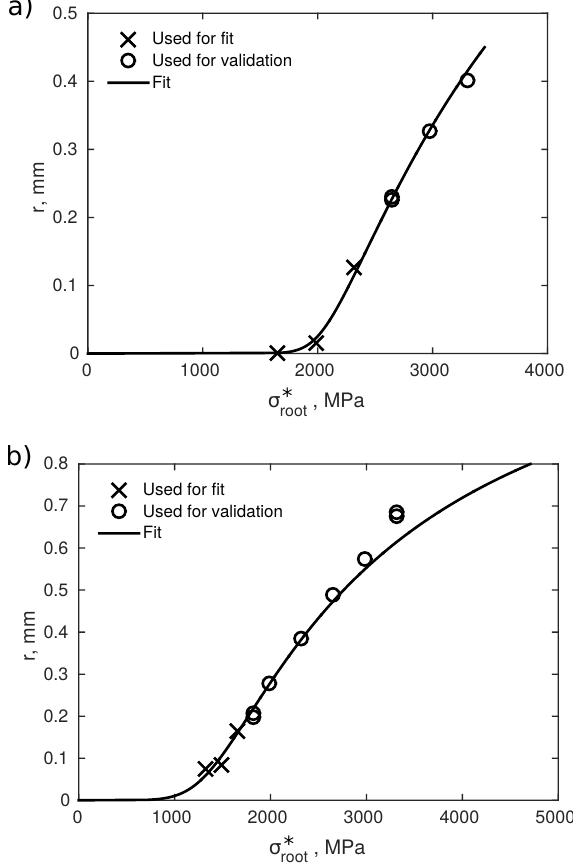
Figure 8. The critical distance, r , as function of the notch root stress from an elastic finite element analysis, σ ∗ root , for: a) 450 °C and b) 550 °C. The fit was done using Eqn. 28; a few points taken at low σ ∗ root were used for